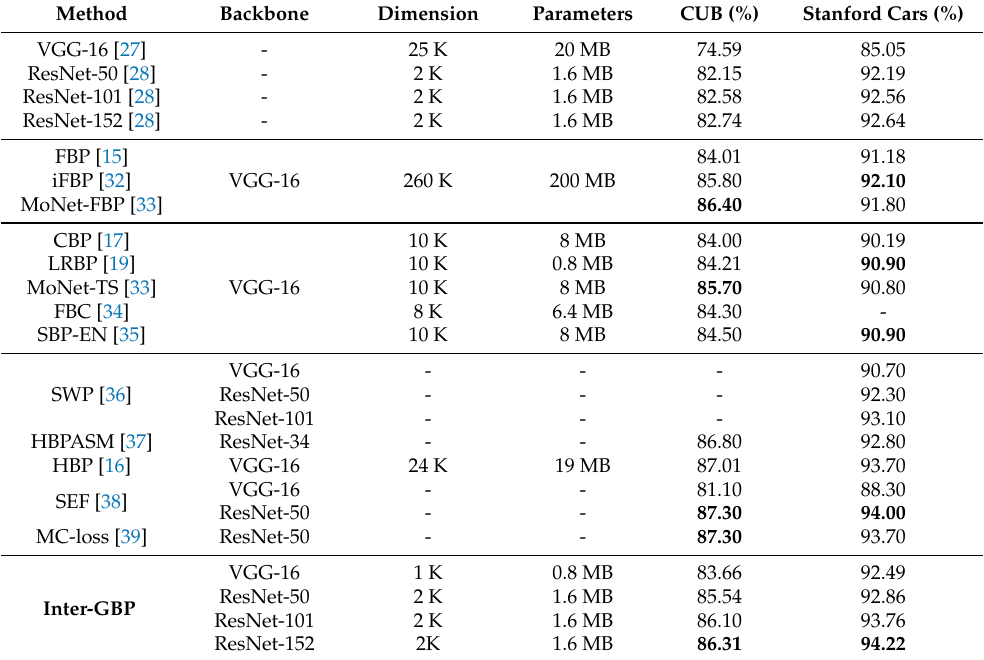
Table 5. The performances of different methods on CUB dataset and Stanford Cars dataset. From top to bottom, the five blocks respectively list the baselines, full bilinear pooling based methods, compact bilinear pooling based methods, other state-of-the-art methods relating to channels and our